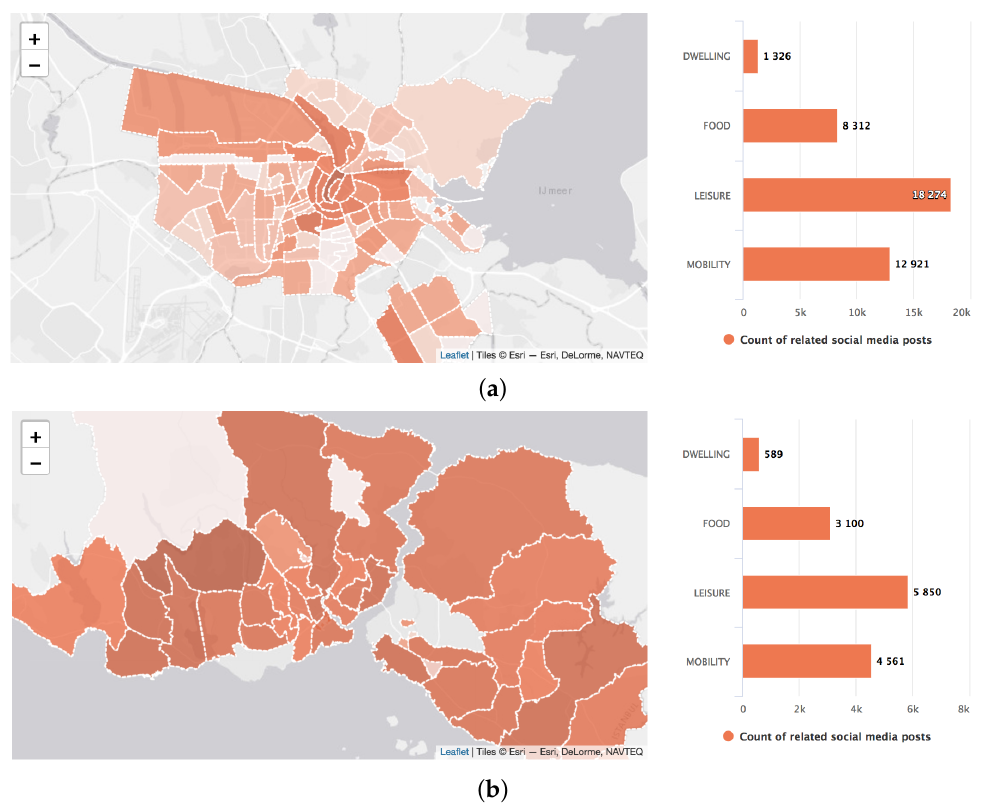
Figure 8. Overall distribution of energy-consuming activities of Amsterdam ( a ) and Istanbul ( b